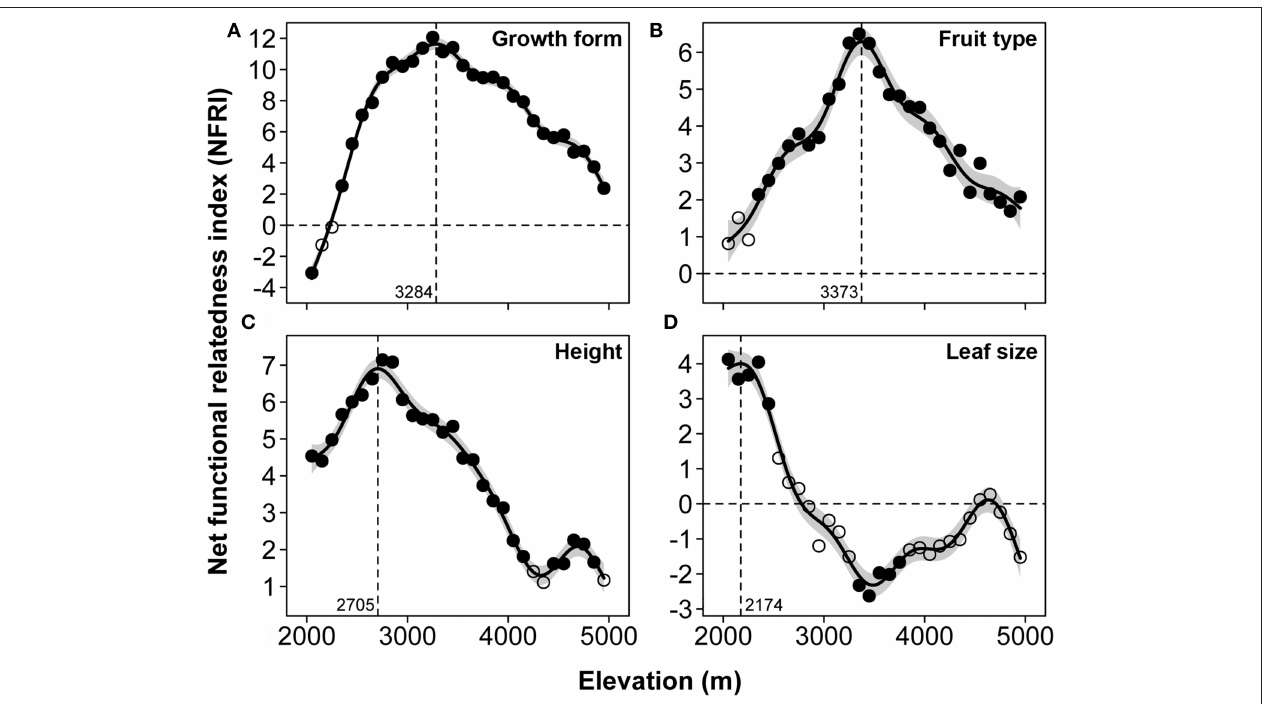
FIGURE 6 | The patterns of net functional relatedness index (NFRI) for the four functional traits, growth form (A) , fruit type (B) , maximum height (C) , and maximum leaf size (D) , along the elevational gradient of Mount Kenya from 2,000 to 5,000m a.s.l. Solid circles denote significant clustering or overdispersion compared to the randomizations.